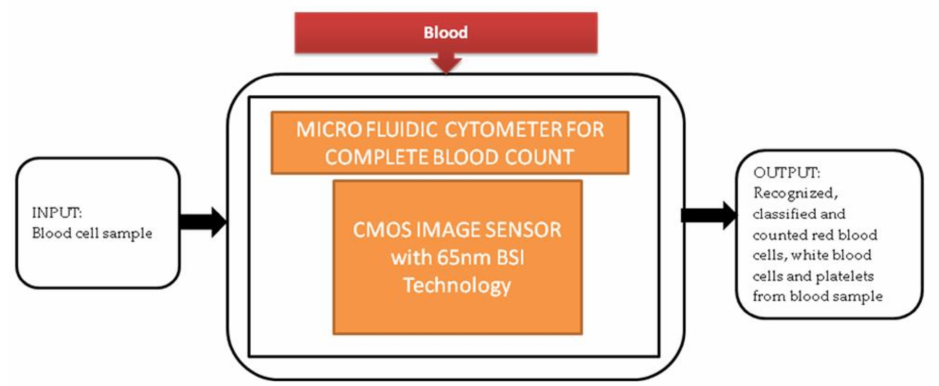
Figure 6. Microfluidic cytometer for a complete blood